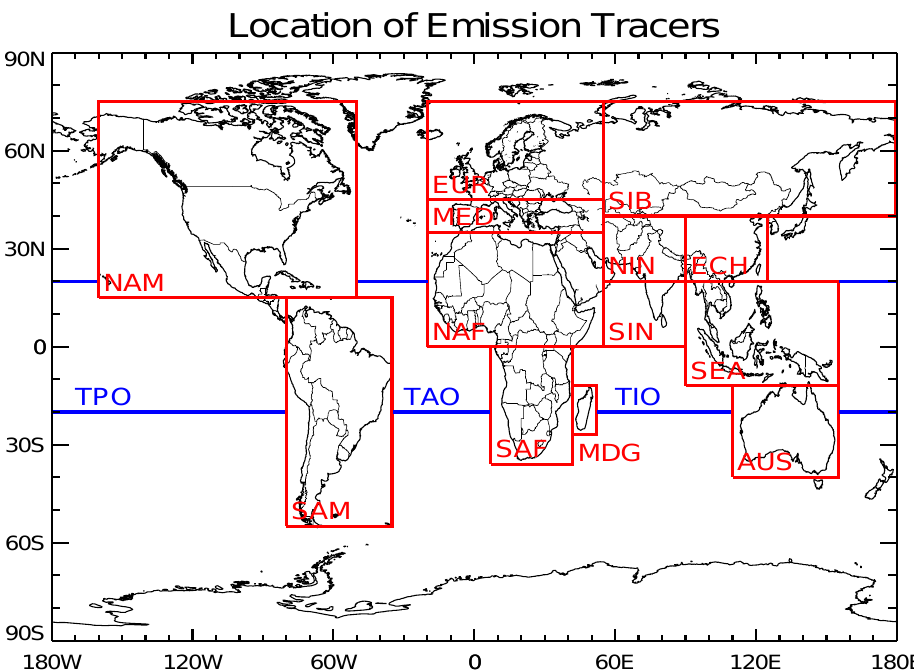
Figure 1. Global geographic location of artificial boundary layer source regions in the CLaMS model, also referred to as “emission tracers”. The latitude and longitude range for each emission tracer is listed in Table